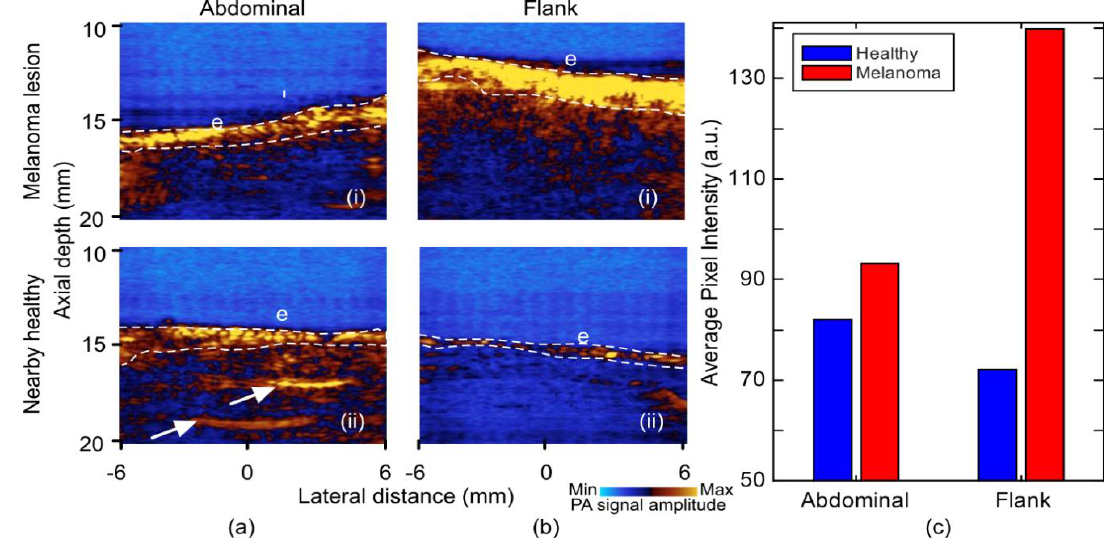
Figure 7. Photoacoustic images of melanoma lesion and nearby healthy skin at 1064 nm illumination wavelength. ( a ) Abdominal: (i) Lesion and (ii) healthy. ( b ) Flank: (i) Lesion and (ii) healthy. ( c ) Bar chart of average pixel intensity from epidermal region at 1064 nm images. E: Epidermis. Fibrotic septa (arrows); averaged epidermal pixels (white dashes).